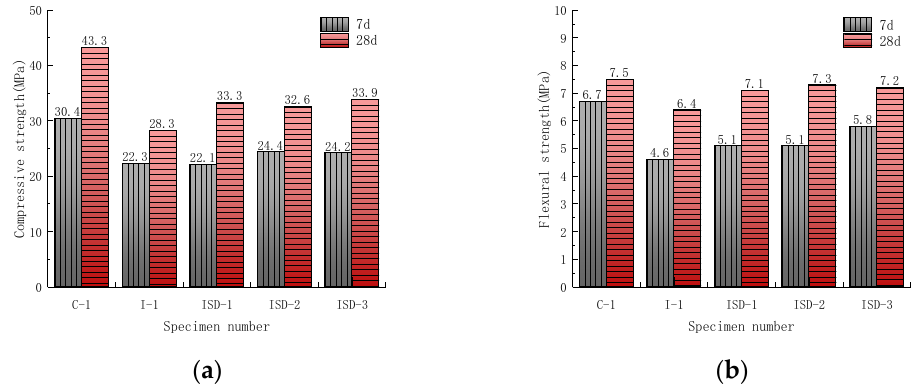
Figure 2. Effect of steel slag doping ratio on ( a ) compressive strength and ( b ) flexural strength of the ISD admixture.